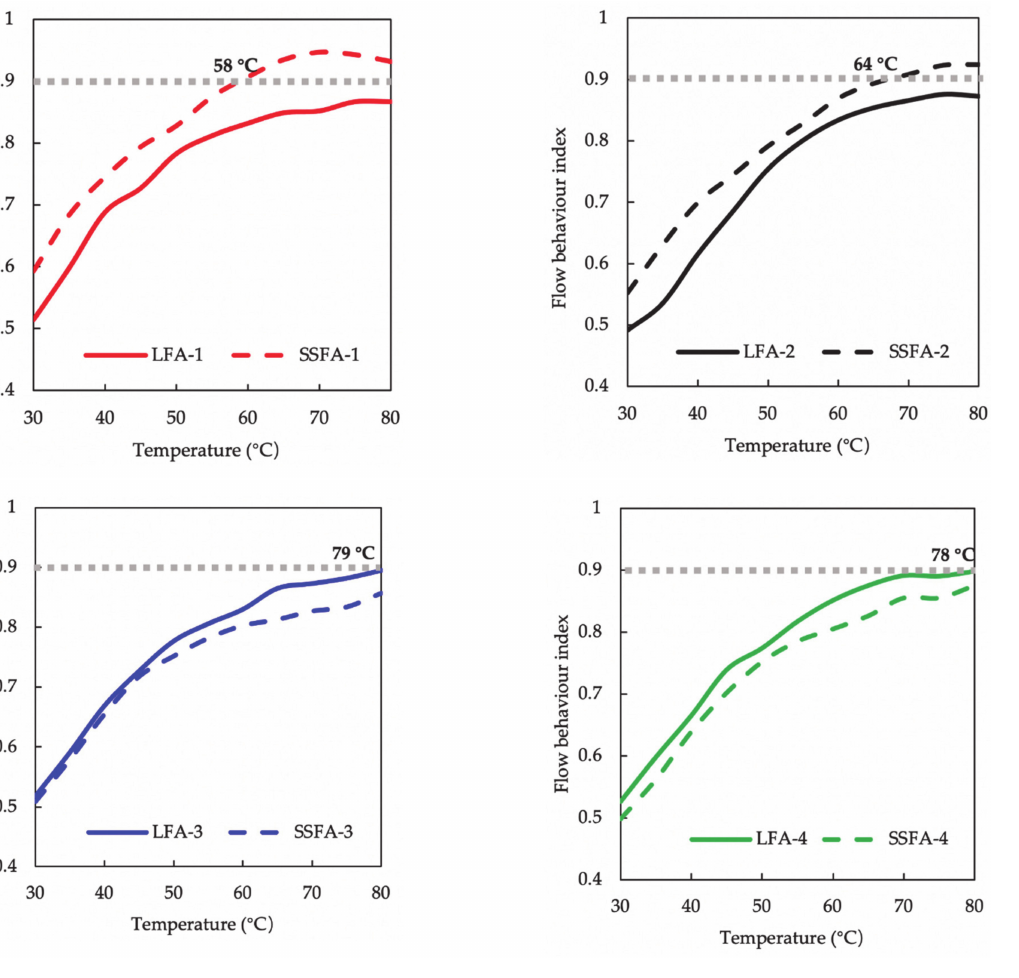
Figure 11. The comparison of SSFA and LFA in self-healing property under various aging methods.